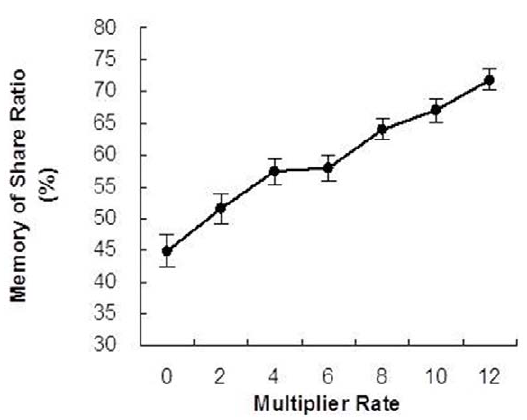
Figure 6. Results of memory tests for the share ratio during the trust game. Graphs show the mean 6 SEM. Participants used an 11-point scale (0% to 100%). doi:10.1371/journal.pone.0051484.g006 male and female participants were students of the Japanese university. No significant difference of age between males (Mean = 21.4, SD = 1.465) and females (Mean = 21, SD = 1.344) were found (t (50) =1.009, p =0.318).